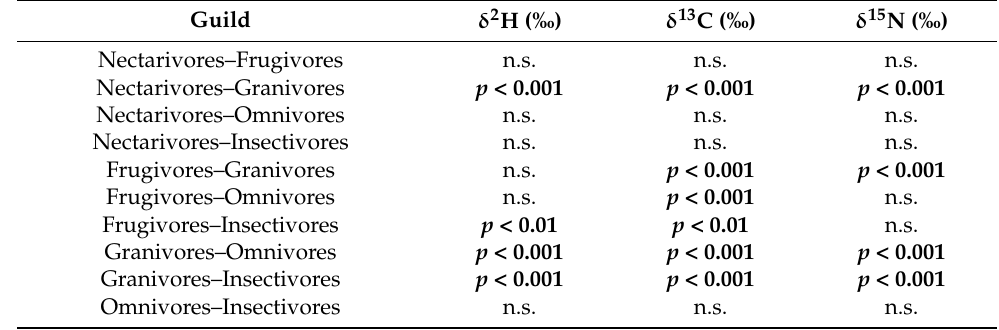
Table 3. Between-guild differences in isotopes based on Tukey post-hoc tests, highlighting between- guild differences in bold (see